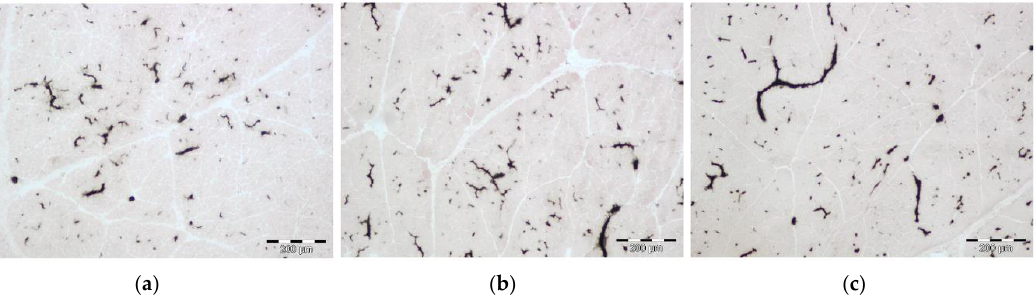
Figure 3. ( a – c ): Alkaline phosphatase/eosin stained longissimus muscle cross sections of piglets at 5, 12 and 26 dpn, respectively. Capillaries were stained black. Scale bar = 200 µm.